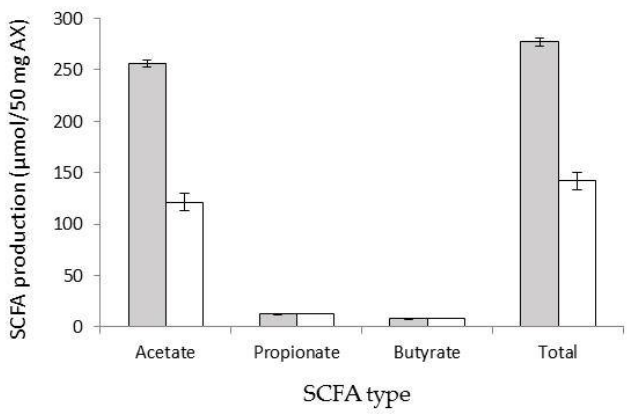
Figure 5. Short-chain fatty acids (SCFA) produced during in vitro fermentation (48 h) of AX ( ■ ) and Control (□, no added carbon source) using colonic bacteria. Each value is expressed as mean ± SD.